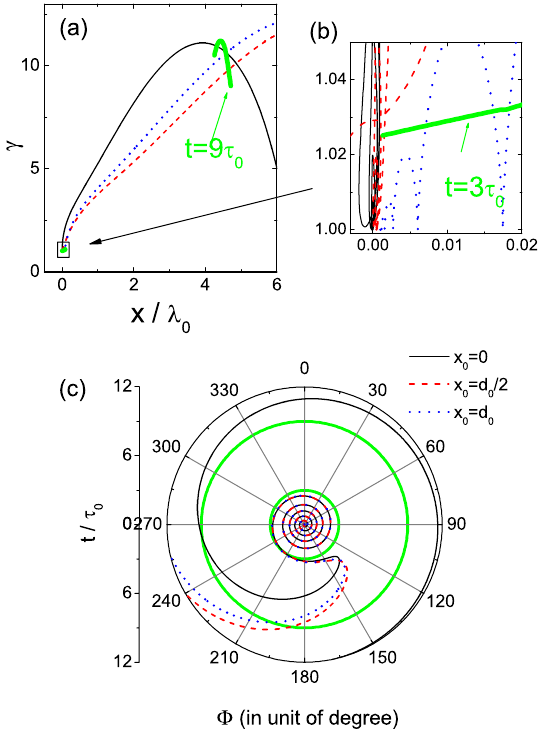
FIG. 2. (a) The spacial evolution of normalized energy of the initial tail ( x 0 ¼ 0 ), middle ( x 0 ¼ d 0 = 2 ), and front ( x 0 ¼ d 0 ) sublayers during the laser pulse. We zoom in part of (a) in (b). (c) The variation of E Ly ’s phase experienced by different sublayers. The chirped parameter is b ¼ 0 : 0635